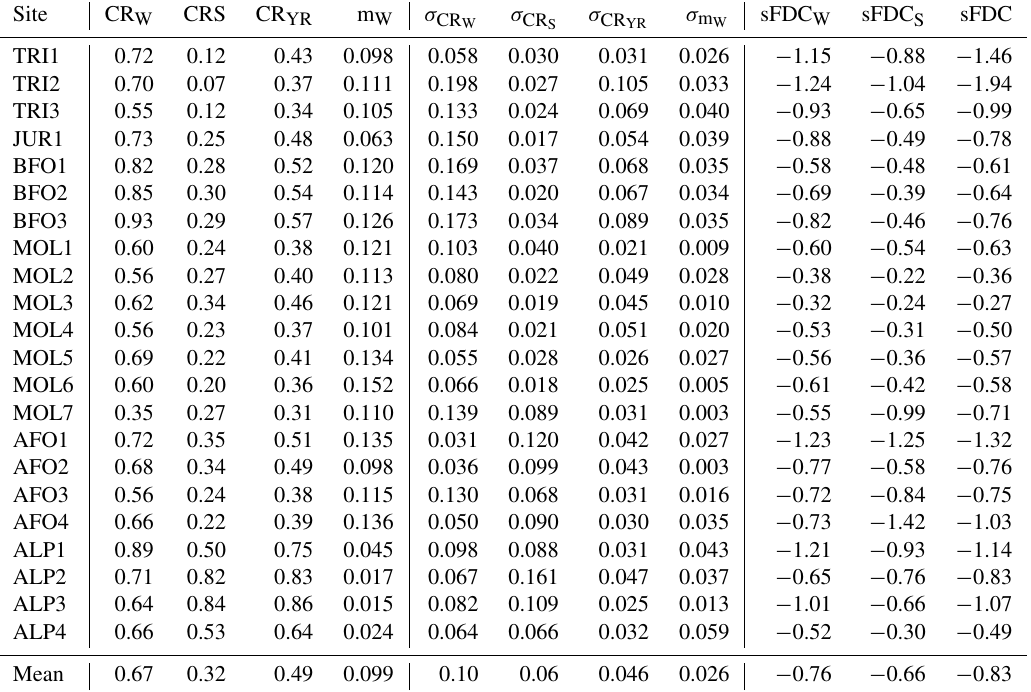
Table 1. Mean seasonal winter (CR W ), summer (CR S ), and annual runoff coefficients (CR YR ) as indicated by the slope of linear regression lines fitted to the different segments of the type I dDMC. The analogue for the type II dDMC is m W , which describes how fast dimensionless relative release grows with the potential renewal rate of the soil stock during winter. The inter-annual variation of these quantities within the hydrological years (1999–2003) is quantified using the mean absolute deviation and is given by σ CR sFDC W , sFDC S , and sFDC characterize the slope of seasonal flow duration curves between the 33rd and 66th percentiles of the dormant period, the period of vegetation, and all data, respectively. The separation of seasons was done using a temperature-index model (Menzel et al., 2003). All quantities are